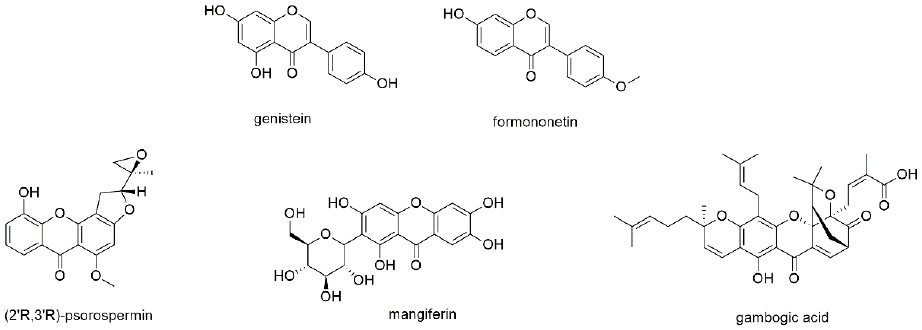
Figure 9. Isoflavones and xanthones with reported activity against myeloma cell lines.